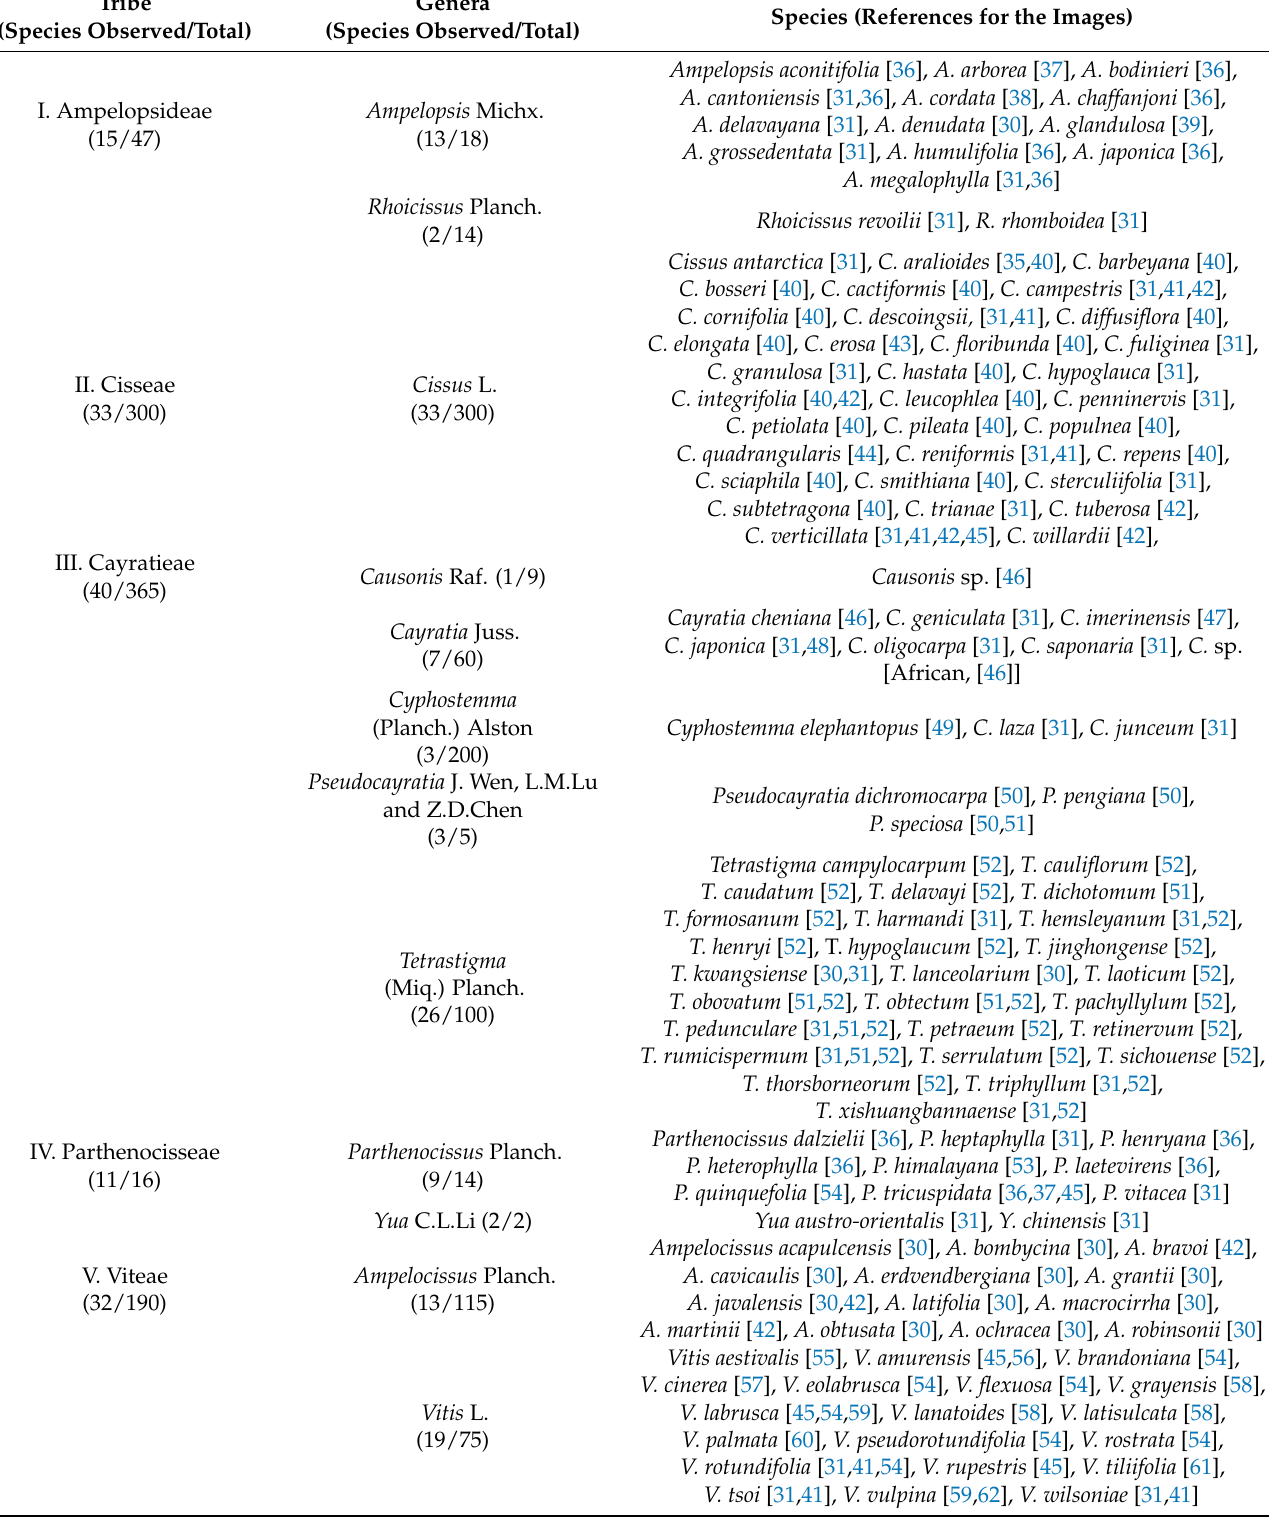
Table 2. A summary of the 131 species for which seed shape has been analysed in this work.